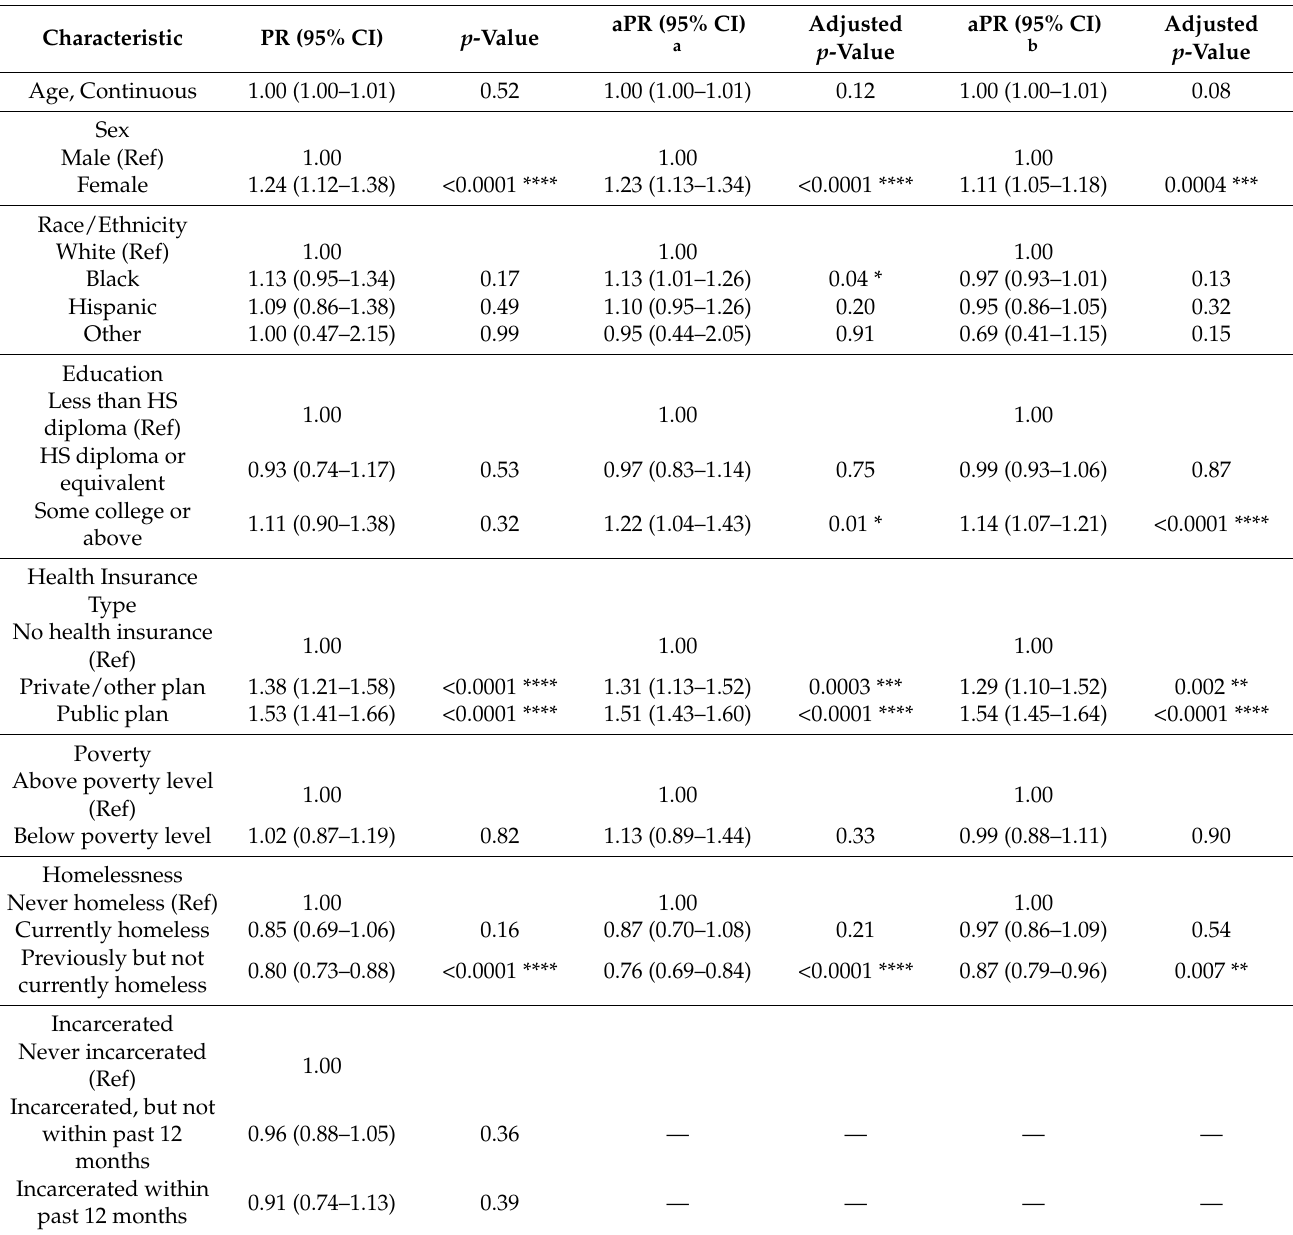
Table 3. Unadjusted and adjusted weighted and unweighted modified Poisson regression models assessing the relationship between healthcare utilization and sociodemographic characteristics in the study population. Healthcare Utilization in the Past 12 Months